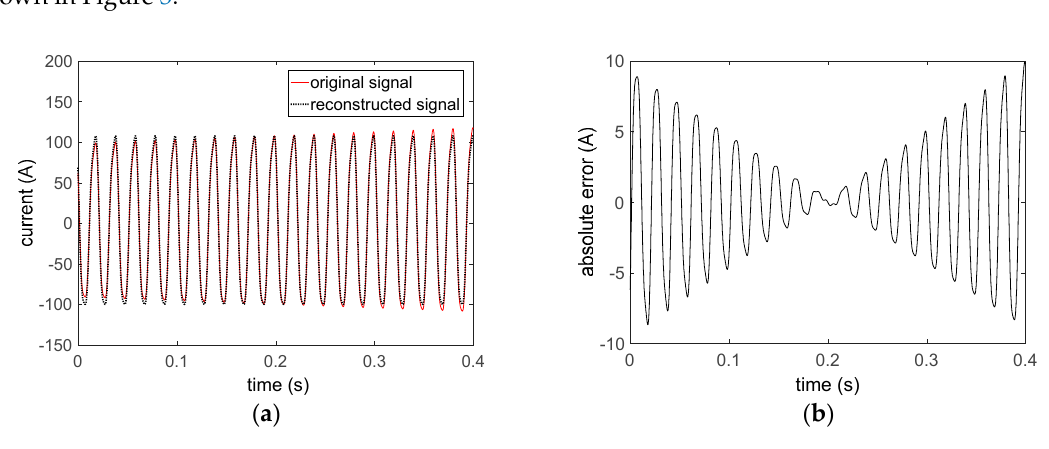
Figure 3. Simulation results of WIFFT: ( a ) Comparison of original signal and reconstructed signal; ( b ) Absolute error of original signal and reconstructed signal.